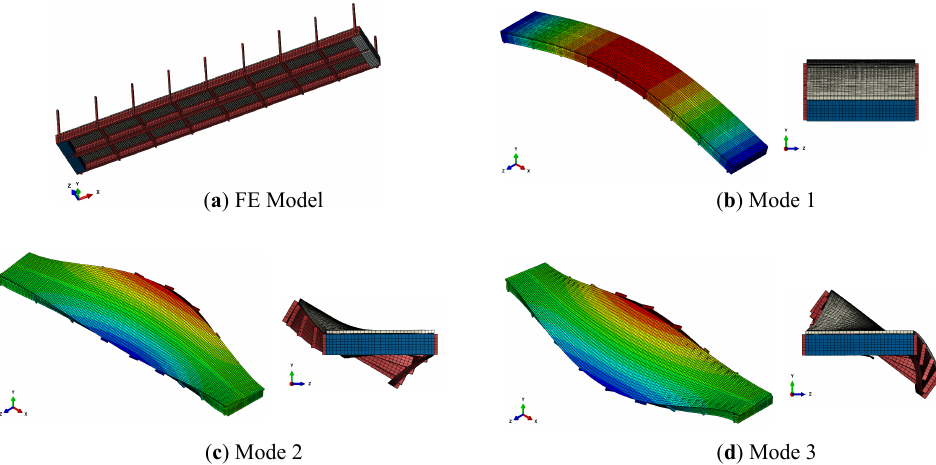
Figure 7. Numerical model of the FRP footbridge: ( a ) Bottom view. ( b ) First vibration mode. ( c ) Second vibration mode. ( d ) Third vibration mode. Table 3. Characterization of properties for the numerical model of the